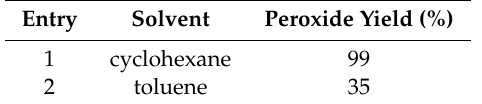
Table 4. The e ff ect of a kind of organic solvent. Reaction conditions: 1-bromobutane 0.21 g, 1.50 mmol;